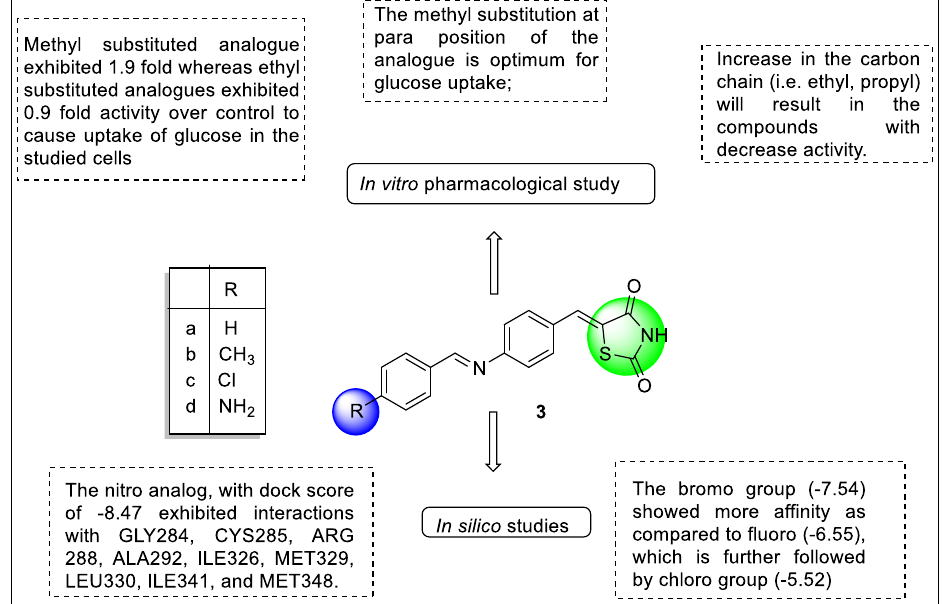
Figure 8. Structural activity relationship of Thiazolidinediones hybrids ( 3 ) as potent PPAR ligands.